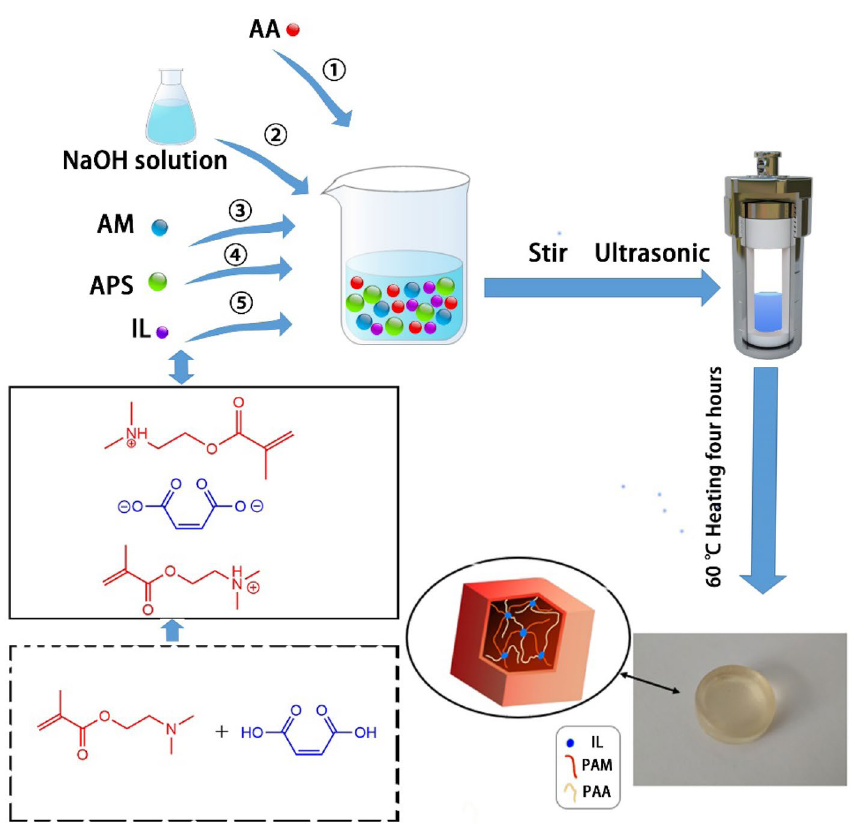
Fig. 1 Preparation of PAA/ PAM/[DMAEMA]MA